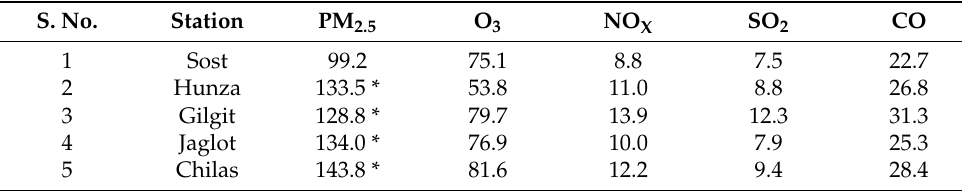
Table 6. AQI values for selected analytes in summer,